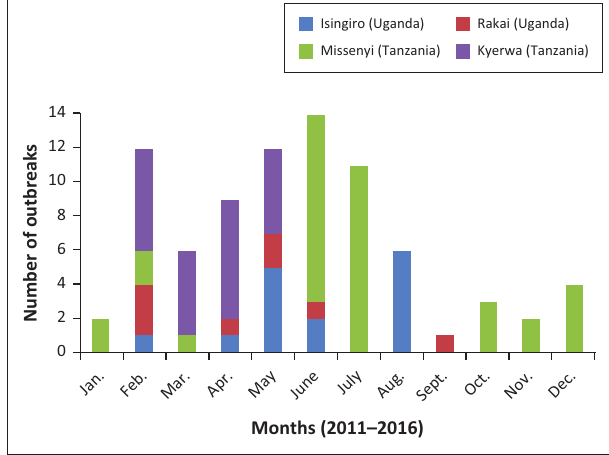
FIGURE 3: Temporal distribution of the number of outbreaks in selected border districts of Uganda and